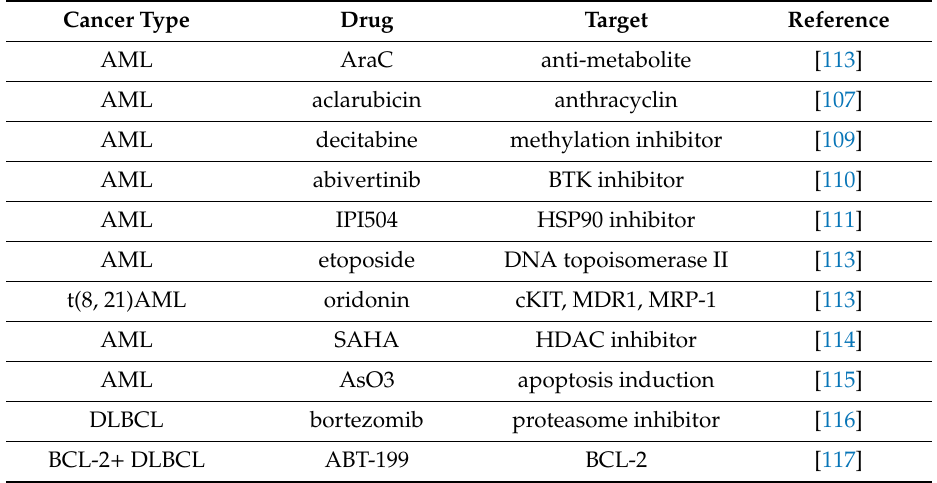
Table 1. Combinations of homoharringtonine with other chemotherapeutic drugs that show potentiating e ff